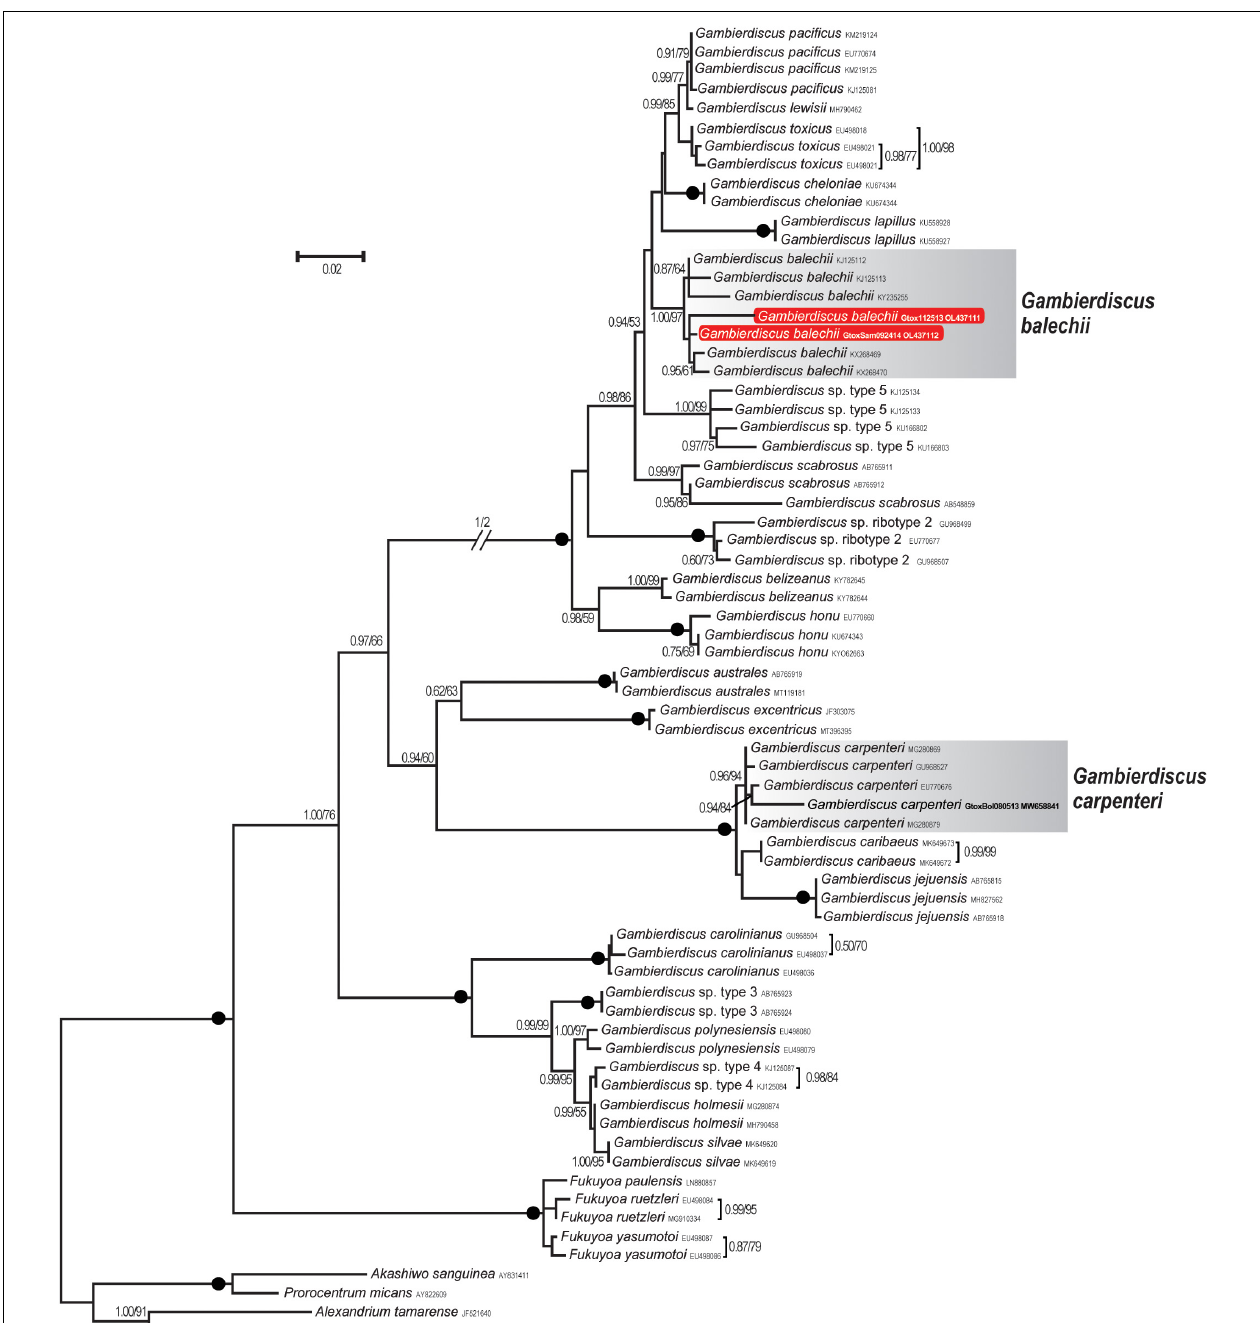
FIGURE 3 | Maximum likelihood (ML) phylogeny of Gambierdiscus species inferred from D8-D10 LSU rDNA (859 bp) based on the GTR + I + G model. Posterior probabilities (PP, ≥ 0.7) of Bayesian inference and bootstrap support (BS, ≥ 50%) values of ML were indicated, and black dots on nodes indicate maximum supports for both BI and ML (PP/BS = 1.00/100). New DNA sequences analyzed in this study are highlighted in red box. Strains used in this study are highlighted in